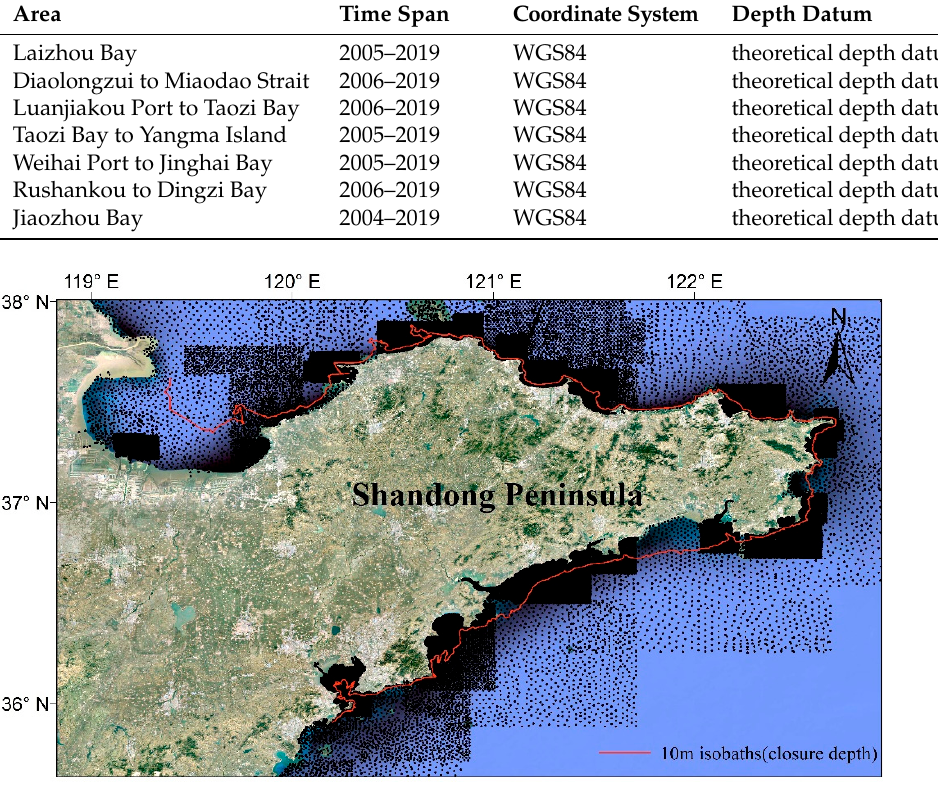
Figure 2. The distribution of original dots, 2019.